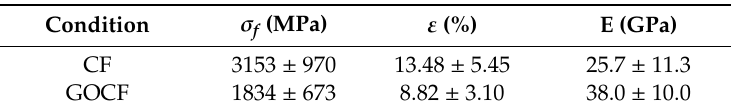
Table 1. Mechanical properties of CF and GOCF.